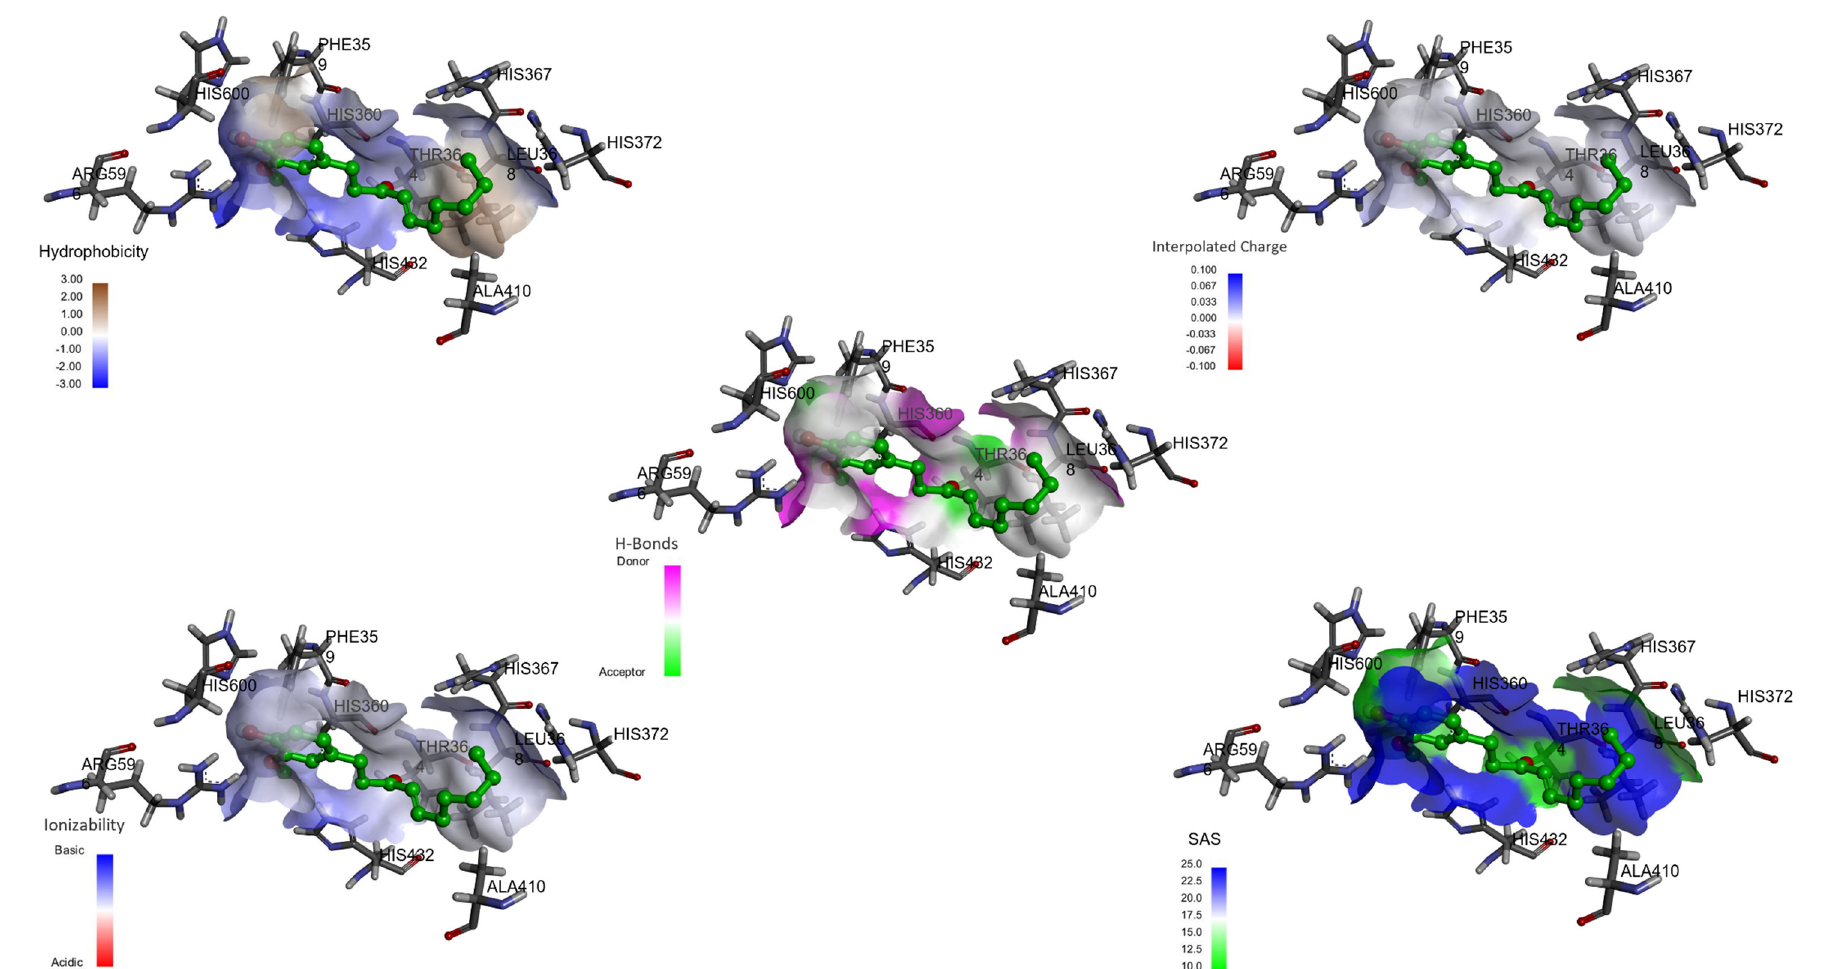
Figure 5. Interactions between the surface of 6-shogaol and 5 − LOX (PDB:6N2W). Physicochemical complex of 6 − shogaol and 5 − LOX evaluating the hydrophobicity, hydrogen bonds, active lateral charge, ionization, and solvent-accessible surface (SASA).